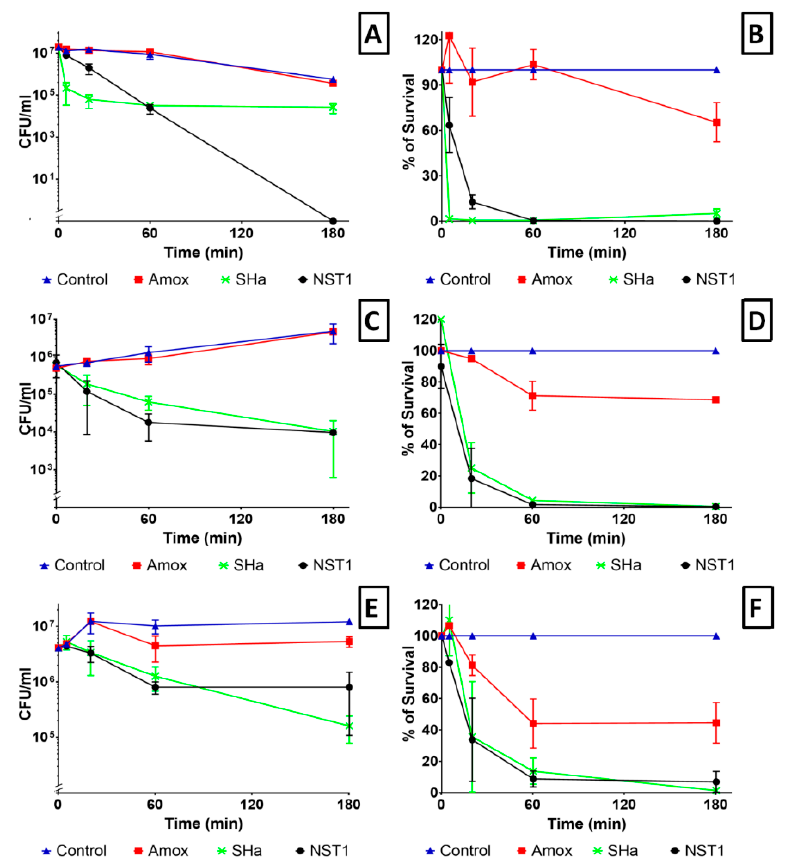
Figure 8. Kinetics of H. pylori (ATCC 43504) killing by temporin-SHa, NST1 and the conventional antibiotic amoxicillin. H. pylori (ATCC 43504) was exposed for 0, 5, 20, 60 or 180 min to 5-times the MIC of peptides or amoxicillin. Number of surviving bacteria was determined as explained in Materials and Methods. Results are expressed in both in number of colony-forming units ( A , C , E ) and in % of bacterial survival ( B , D , F ). Conditions tested were PBS pH 6 ( A , B ), PBS pH 6 with porcine gastric mucins MUC2 and MUC3 ( C , D ) and PBS pH 6 in the presence of human mucins produced by N87 cells ( E , F ).